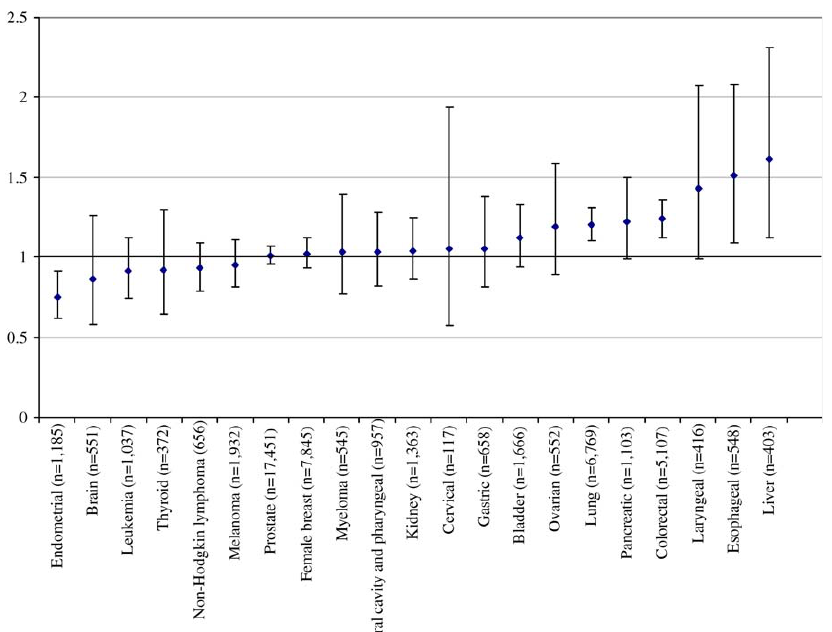
Figure 1. HRs and 95% CIs for the 5th Versus 1st Quintile of Red Meat Intake and Cancer Risk for Both Sexes Combined (Except for Sex-Specific Cancers)